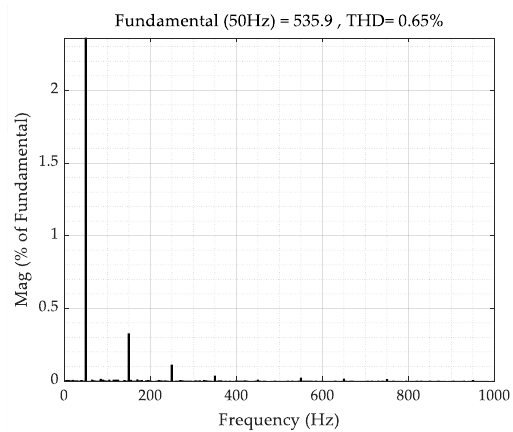
Figure 19. THD value of MMC-RPC output current.